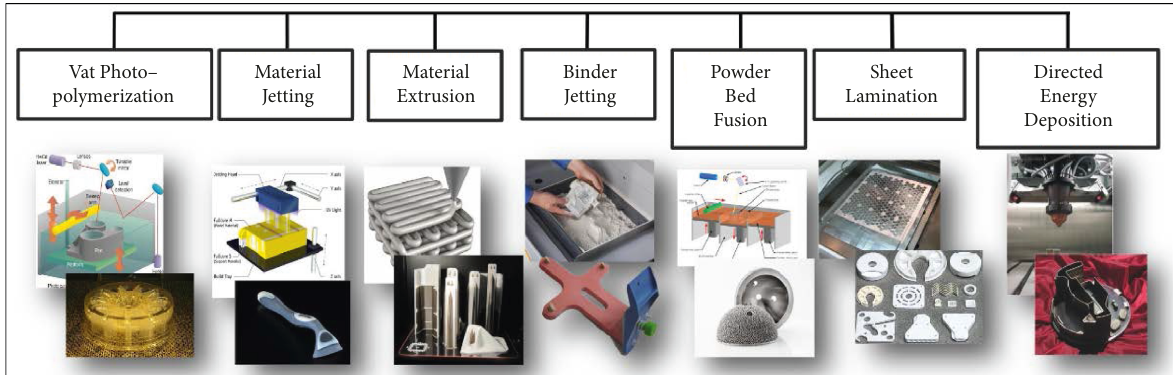
Figure 1: Additive manufacturing processes.